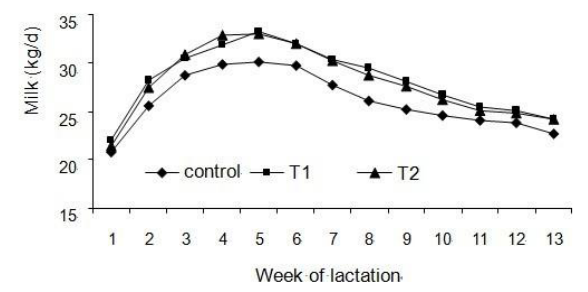
Figure 1. Milk yield of cows from three treatments: Control is basal diet without HMBi; T1 is basal diet plus HMBi initiated from 21 d prepartum to 91 d postpartum; and T2 is basal diet plus HMBi initiated from calving to 91 d postpartum. Milk yield tends to increase for T1- and T2-treated cows compared with the control cows (p = 0.06 and 0.09,